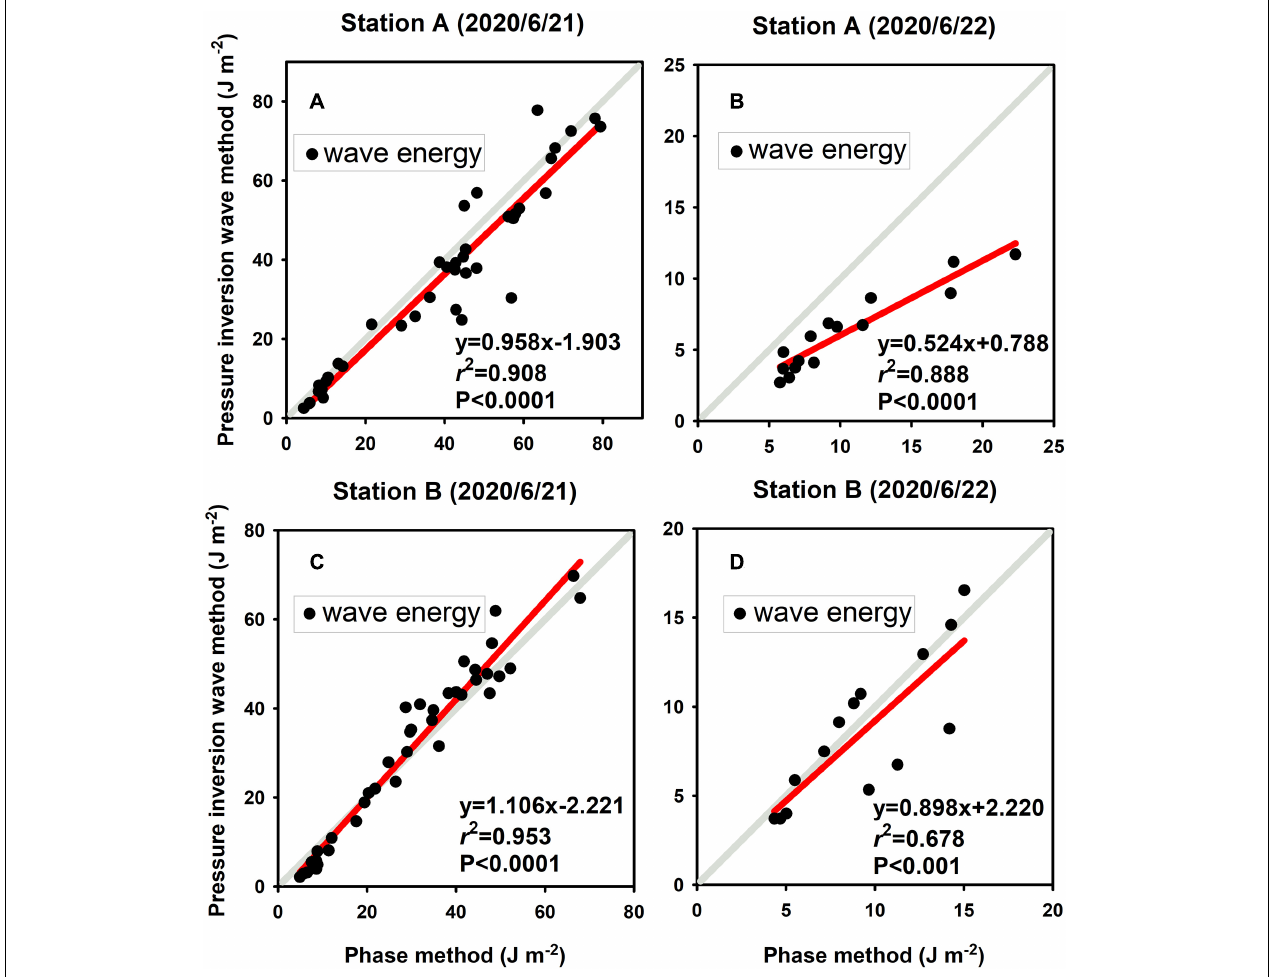
FIGURE 3 | (A–D) Results of correlation analysis of wave energy calculated by phase method and pressure inversion wave